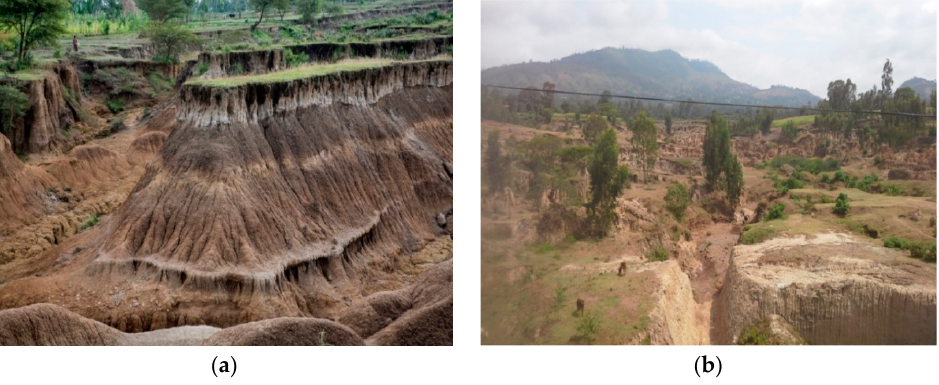
Figure 3. Soil erosion and land degradation in Wolayita ( a ) and Kembata Tembaro ( b ) zones in Bilate catchment, ACB.